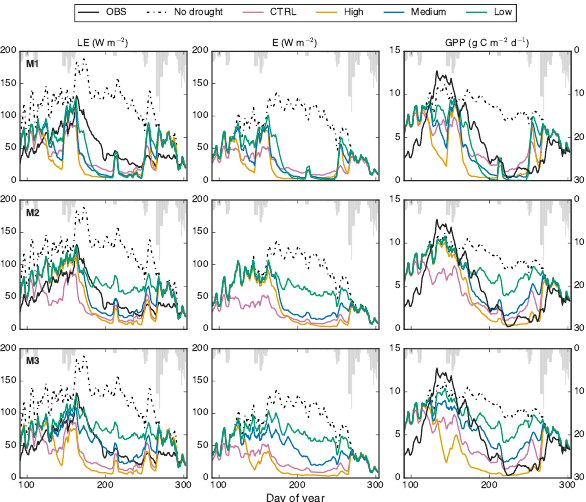
Figure 4. A comparison of the observed (OBS) and modelled la- tent Heat (LE), transpiration ( E ) and gross primary productivity (GPP) at the Hesse site during 2003. Simulations show the con- trol (CTRL) and the three parameterisations that represent a spec- trum of behaviour ranging from a high to low drought sensitivity, and the tested methods to obtain a weighted estimate of soil water potential ( (cid:57) S ) across CABLE’s soil layers (M1–M3). M1 uses a root-biomass weighted soil water content converted to (cid:57) S , M2 cal- culates (cid:57) S by integrated soil water content over the top 1.7m of the soil, and M3 is calculated using a dynamic weight across soil layers. The data have been smoothed with a 5-day moving window to aid visualisation and the grey bars show daily rainfall.